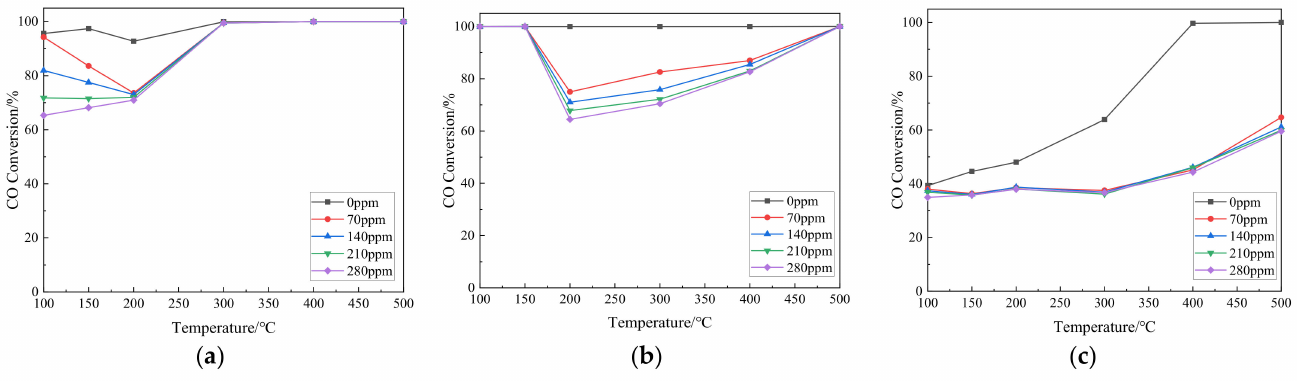
Figure 11. The effect of SO2 concentration on CO conversion: ( a ) Fe 0.8 Cu 0.2 /RHA; ( b ) Fe 0.67 Cu 0.33 /RHA; ( c ) Fe 0.5 Cu 0.5